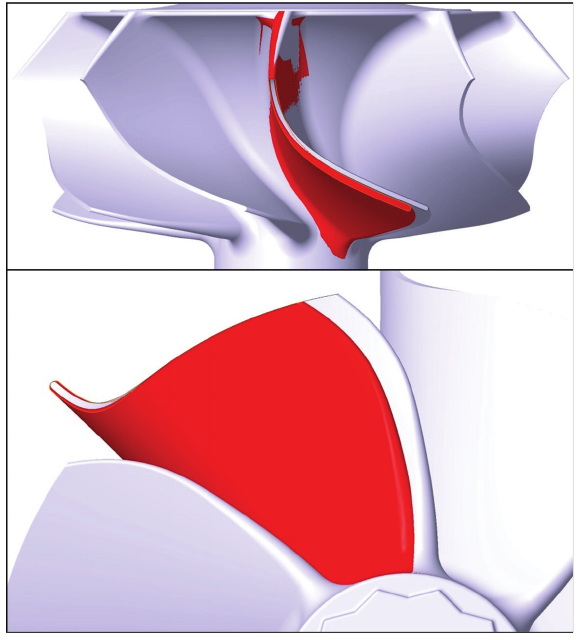
Figure 20: Comparison of nickel-base alloy and γ -TiAl turbine wheel